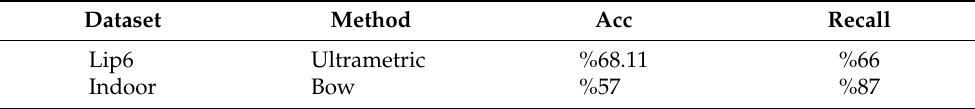
Table 6. Accuracy and Recall for Lip6indoor dataset considerin TUM sequence 16 as training